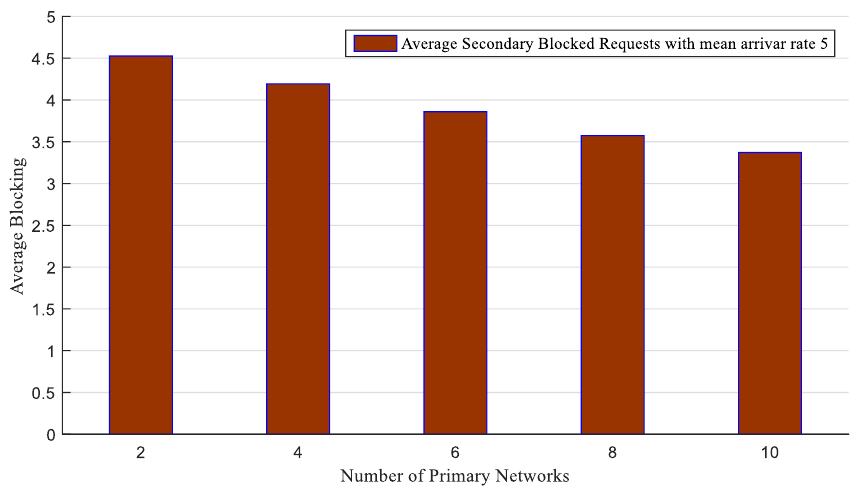
Figure 8. Average secondary blocked requests on a varying number of primary